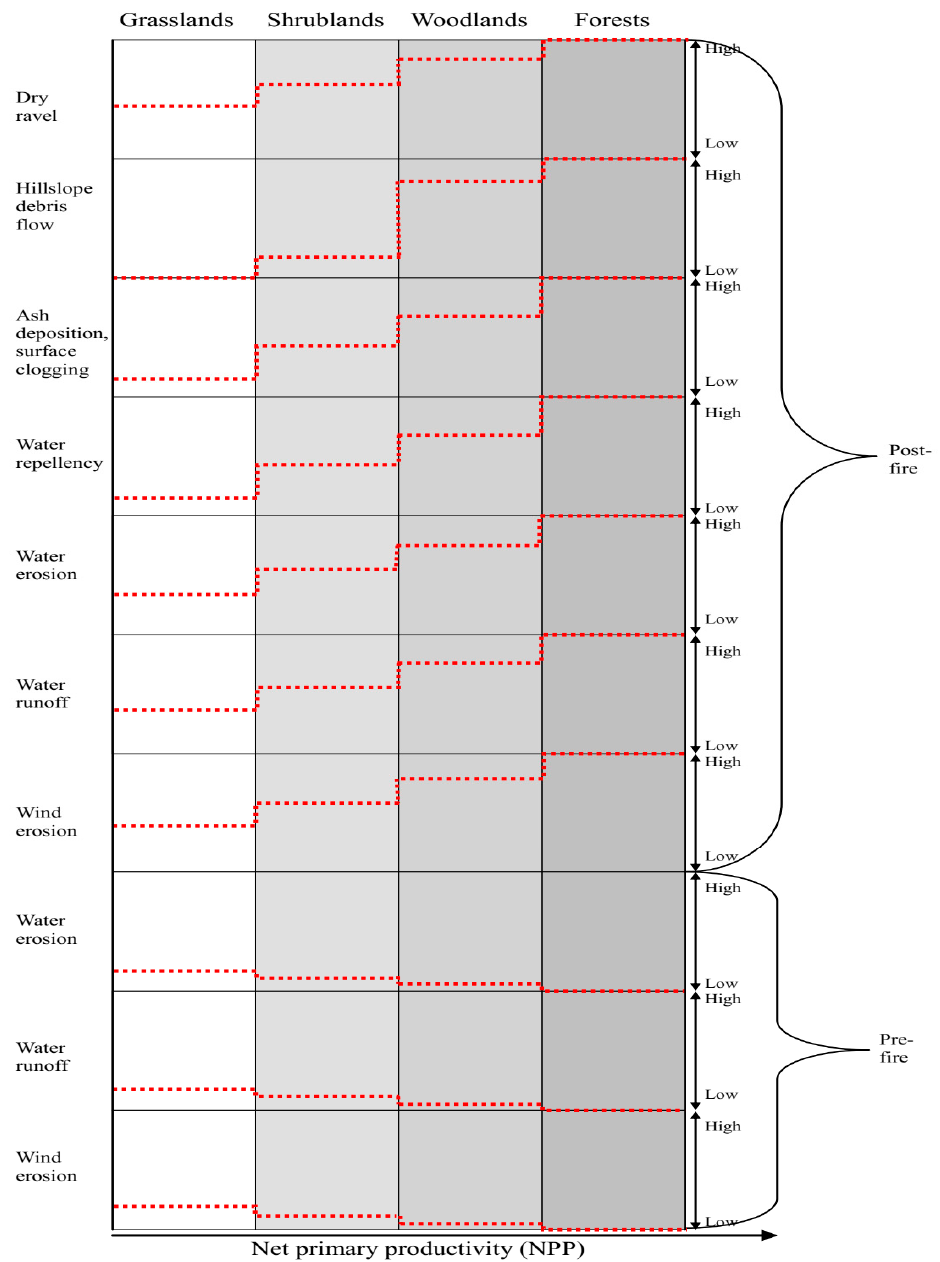
Figure 2. Conceptual illustration of the relative magnitude of the main surface processes under pre- and post-fire conditions. Notes: Under pre-fire conditions, well-functioning ecosystems allow the maximal on-site retention of resources. Therefore, wind erosion, water runo ff , and water erosion, are low. Yet, the extent of these processes is negatively a ff ected by NPP, and follows the trend of grasslands > shrublands > woodlands > forests. Under post-fire conditions, the reduction in aboveground biomass increases these processes. Yet, the fastest and slowest vegetation recovery in grasslands and forest vegetation, respectively (with the rate of shrublands and woodlands vegetation recovery being in between), dictate the extent of these processes. In addition, fires ‘bake’ the ground surface, making it water-repellent. Also, ash deposition causes the clogging of the ground surface. These two processes are positively a ff ected by NPP, and therefore, are lowest in the grasslands, and highest in the forests. Hillslope debris flows do not occur in burnt grasslands, and at the same time, are maximal in burnt forests. The extent of dry ravel is similar to that of post-fire processes of wind erosion, water runoff, and water erosion, and is negatively affected by the rate of vegetation recovery.